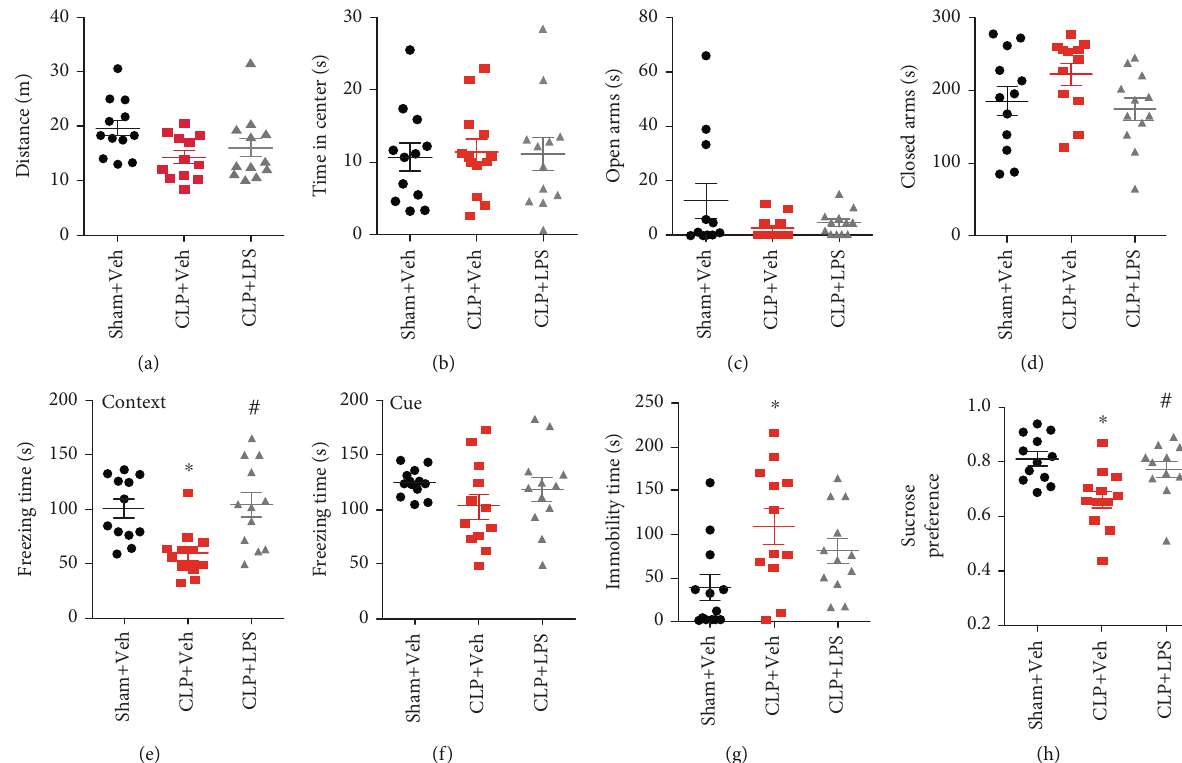
Figure 2: E ff ects of repeated LPS injections and CLP on neurobehavioral outcomes. CLP induced a signi fi cantly decreased freezing time to context, immobility time, and sucrose preference which were observed in the CLP group, whereas repeated LPS injections prevented the decreased freezing time to context and sucrose preference. Data represent mean ± SEM ; n = 12 /group. ∗ P < 0 : 05 vs. sham + Veh group; # P < 0 : 05 vs. CLP+Veh group. LPS: lipopolysaccharide; CLP: cecal ligation and puncture; Veh: vehicle.